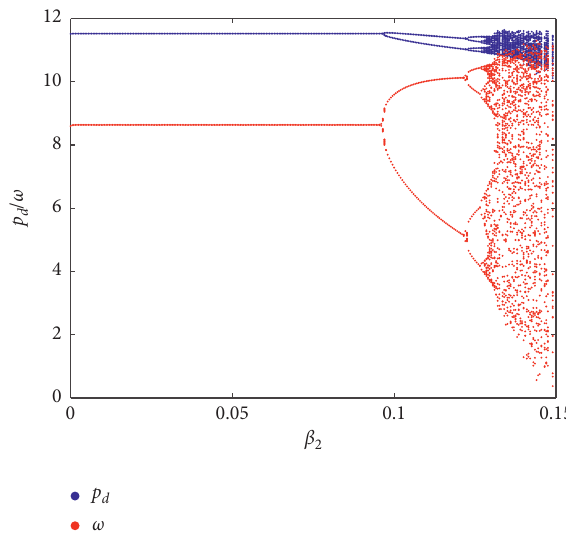
Figure 3: Bifurcation diagram of p